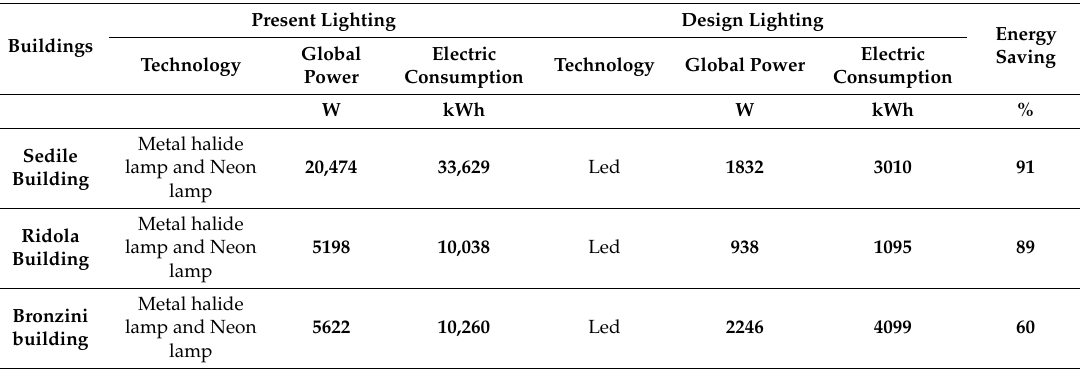
Table 13. Energy analysis of present lighting and design lighting for the three